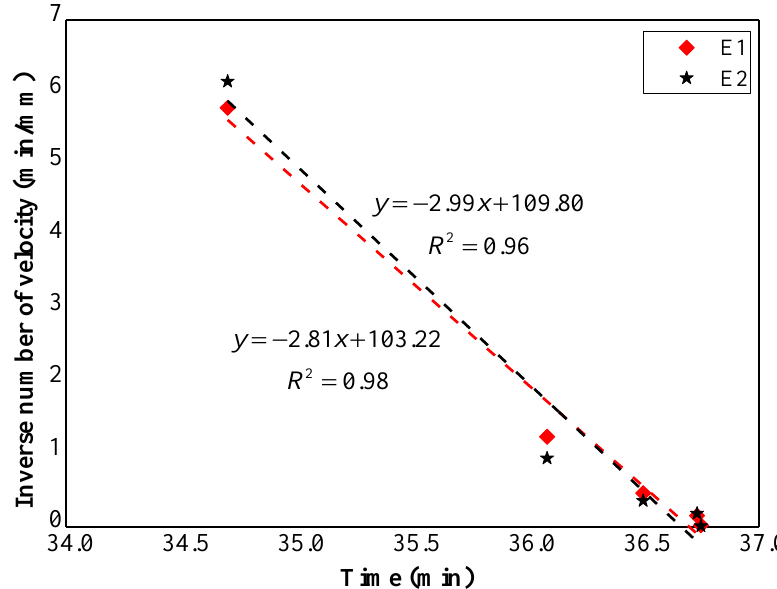
Figure 6. ( a ) Time history of the displacement at the slope surface in Model Test 1, ( b ) time series of the tilting angle at the slope surface.